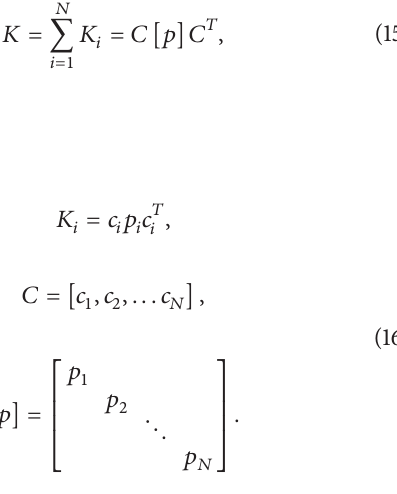
which can be obtained by the spectral decomposition of each elemental stiffness matrix [15, 16]. Generally, the elemental stiffness matrix 𝐾 𝑖 is not of full rank in most cases. Without loss of generality, for convenience of the following derivation, all the ranks of elemental stiffness matrices are presumed to be 1 (other cases with the rank greater than 1 are also valid). Using the spectral decomposition, the